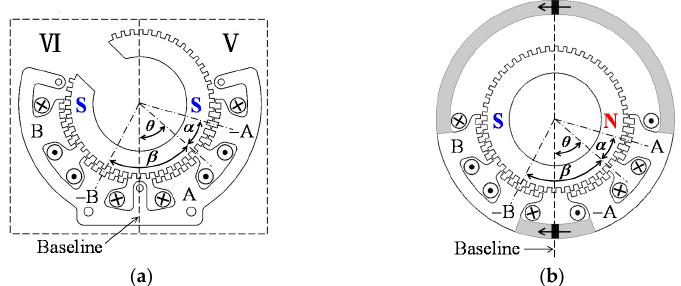
Figure 6. Simplified 2-D equivalent motor model of sub-motor1. ( a ) Equivalent form of Figure 4c; ( b ) The simplified 2-D motor model corresponding to part I + VI.